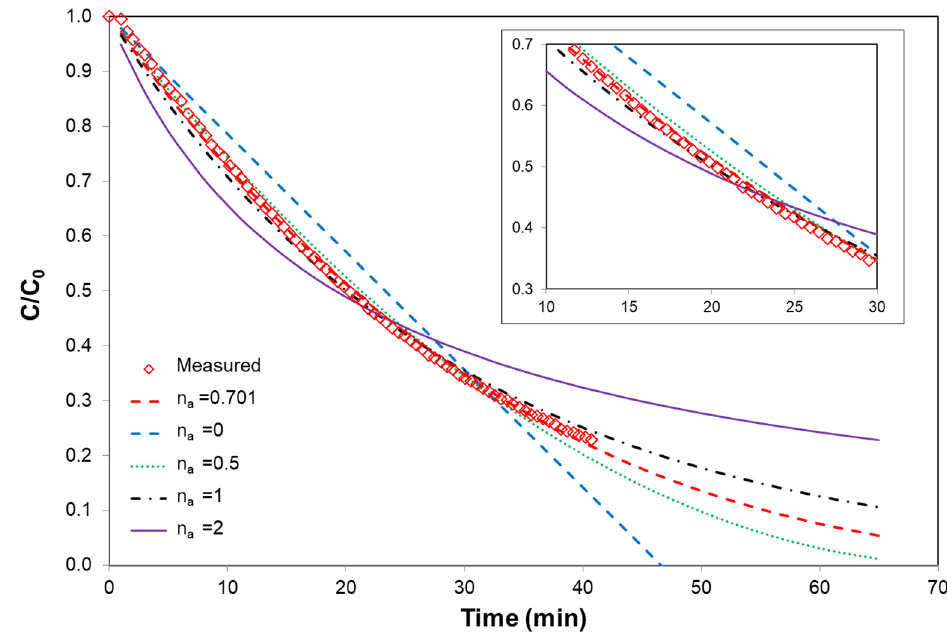
Figure 3. Photocatalytic degradation of 20 μ M ofloxacin in the presence of 2 mg L − 1 H 2 O 2 . Red squares represent measured values, whereas lines represent different calculated amounts using Equations (2) and (3) and optimized kinetic coefficient parameters (see Table 1). Inset emphasizes fits and differences close to t 1/2 = 20.7 min.